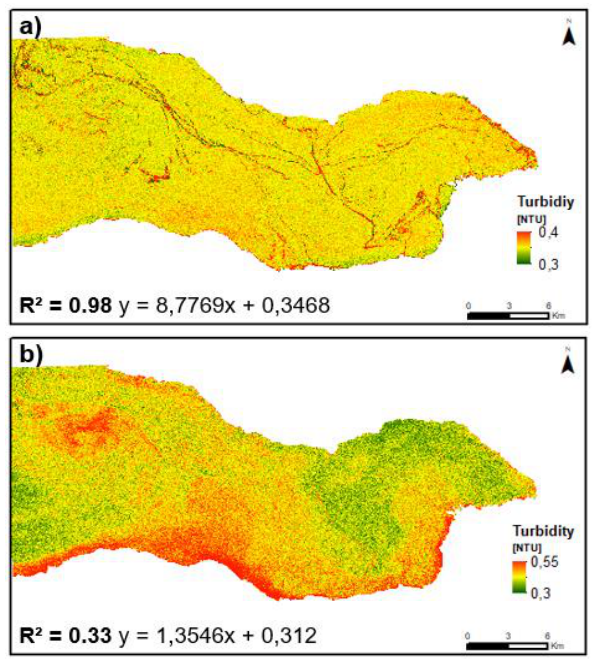
Figure 4. The best regression models for the estimation of the turbidity with a) 5 mucilage samples, b) 16 samples.